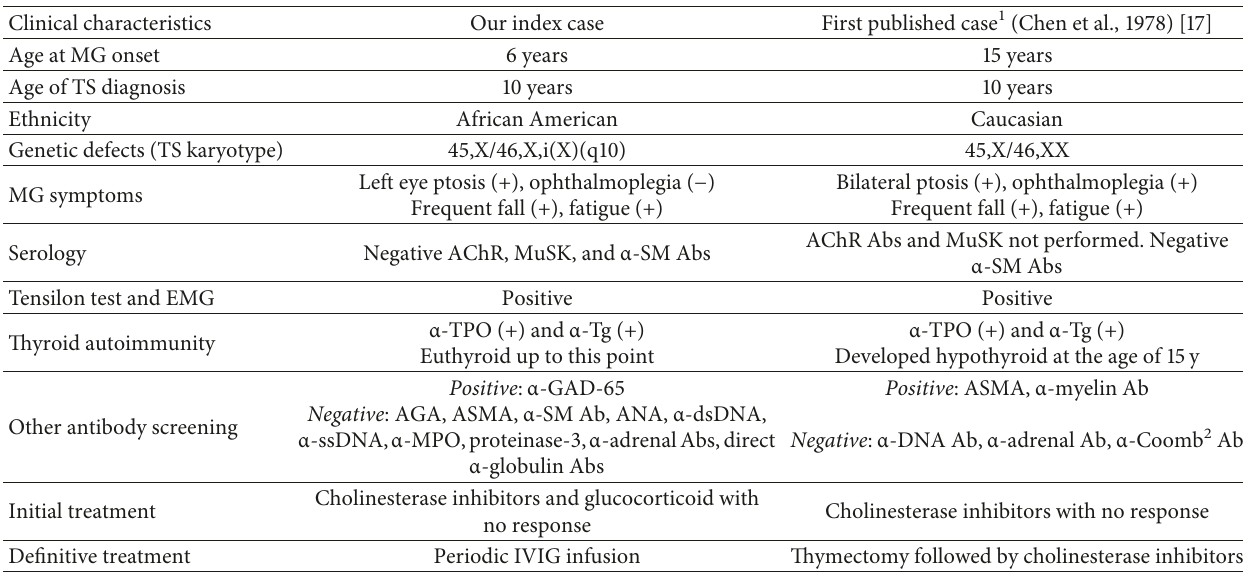
Table 2: Clinical characteristics of our patient compared to the first reported case of TS affected with